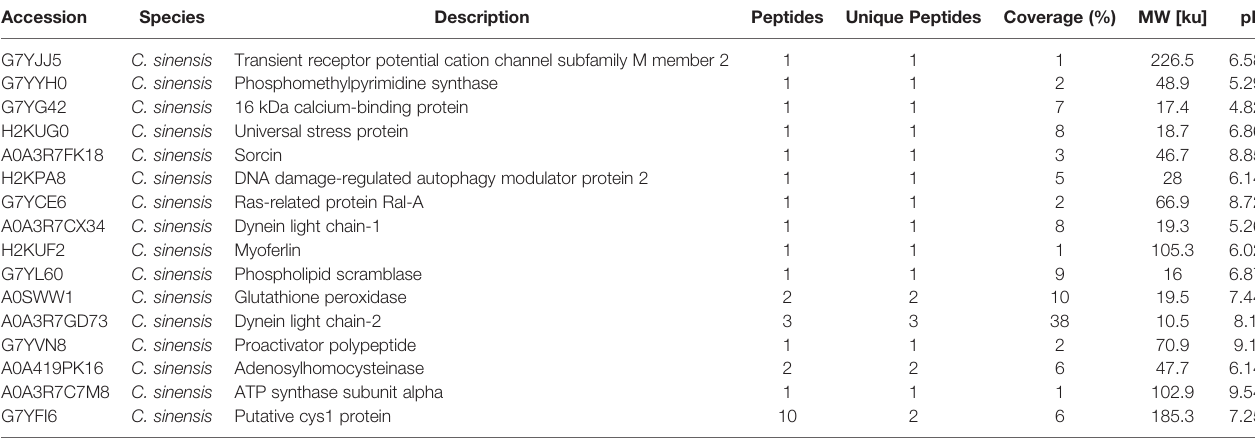
TABLE 3 | Clonorchis sinensis excretory and secretory products which were detected by sera of rabbits in 35 dpi.